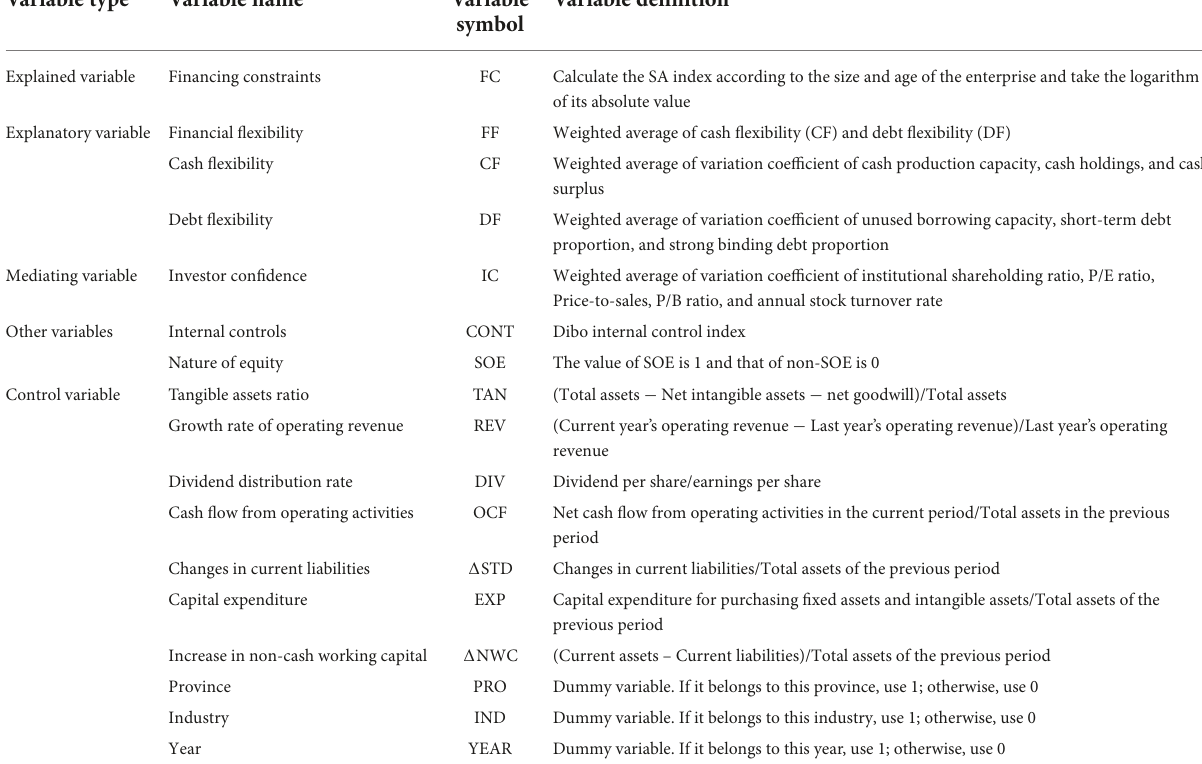
TABLE 2 Variable